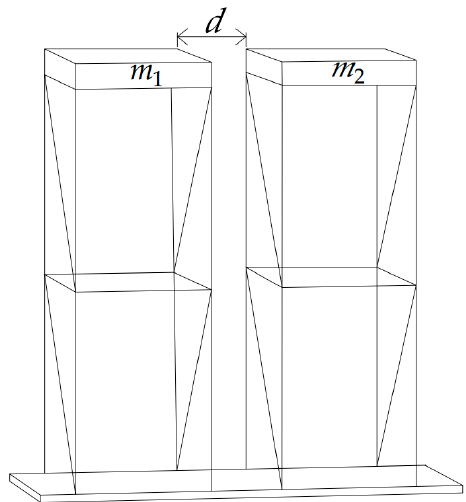
Figure 10. Sketch of two steel structures (tower models) with impacting concrete elements during the